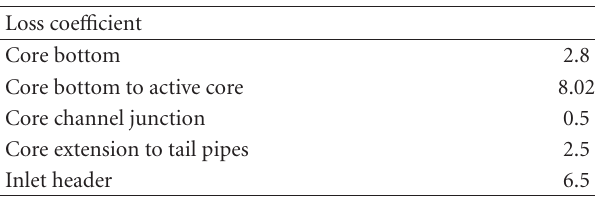
Table 2: Loss coe ffi cients.